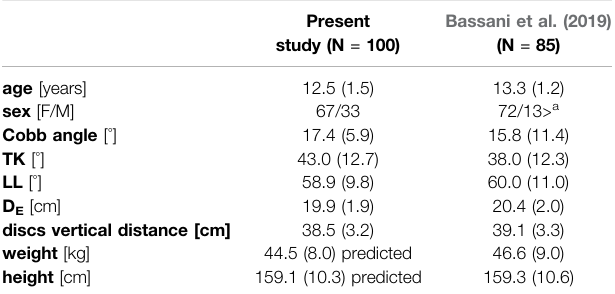
TABLE A1 | values of the parameters, expressed as mean (SD) or number of cases, for the subjects evaluated in the present study and for the dataset with known weight and height values.